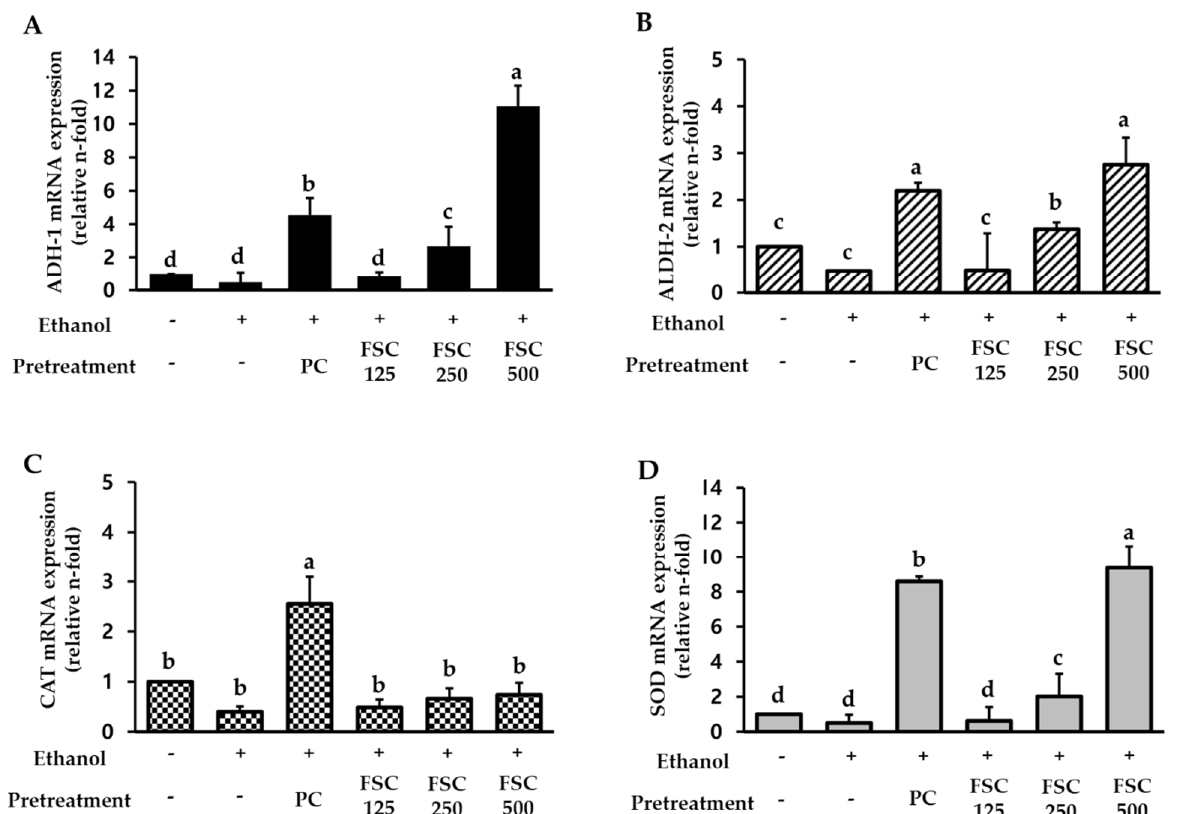
Figure 4. The effect of FSC on mRNA expression of alcohol metabolism-associated enzyme ( A ) and antioxidant enzyme ( B , C ) in rat livers after acute alcohol consumption. Livers were collected 5 h after ethanol administration. The relative mRNA expression levels of ADH-1, ALDH-2, CAT, and ( D ) SOD associated with alcohol metabolism or antioxidant activity were determined by RT-PCR. Data represent the mean ± SEM (n = 6). Bars with different letters show significant differences between groups ( p < 0.05) determined by analysis of variance and Tukey’s multiple comparison